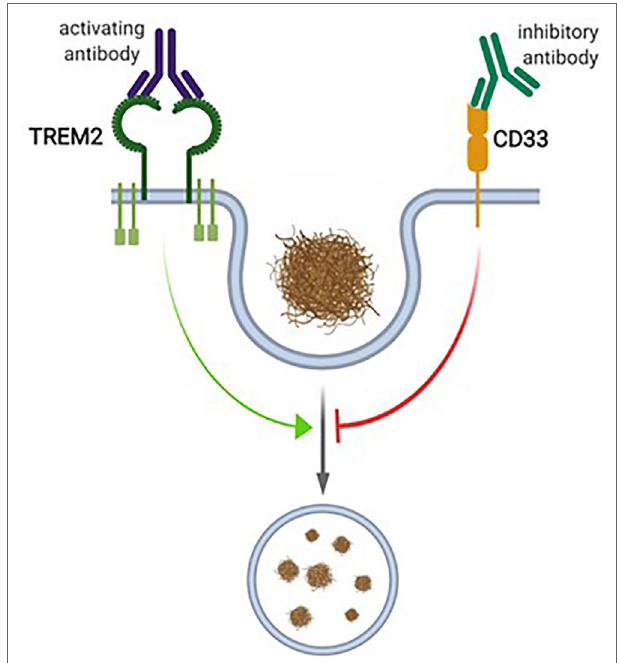
FIGURE 2 | The proposed interplay between CD33 and TREM2 in microglial phagocytosis. CD33 and TREM2 have been proposed to be inhibitors or activators of microglial phagocytosis, respectively. For TREM2, activating antibodies, and for CD33, inhibitory antibodies, have been proposed as therapeutic interventions. Figure created with